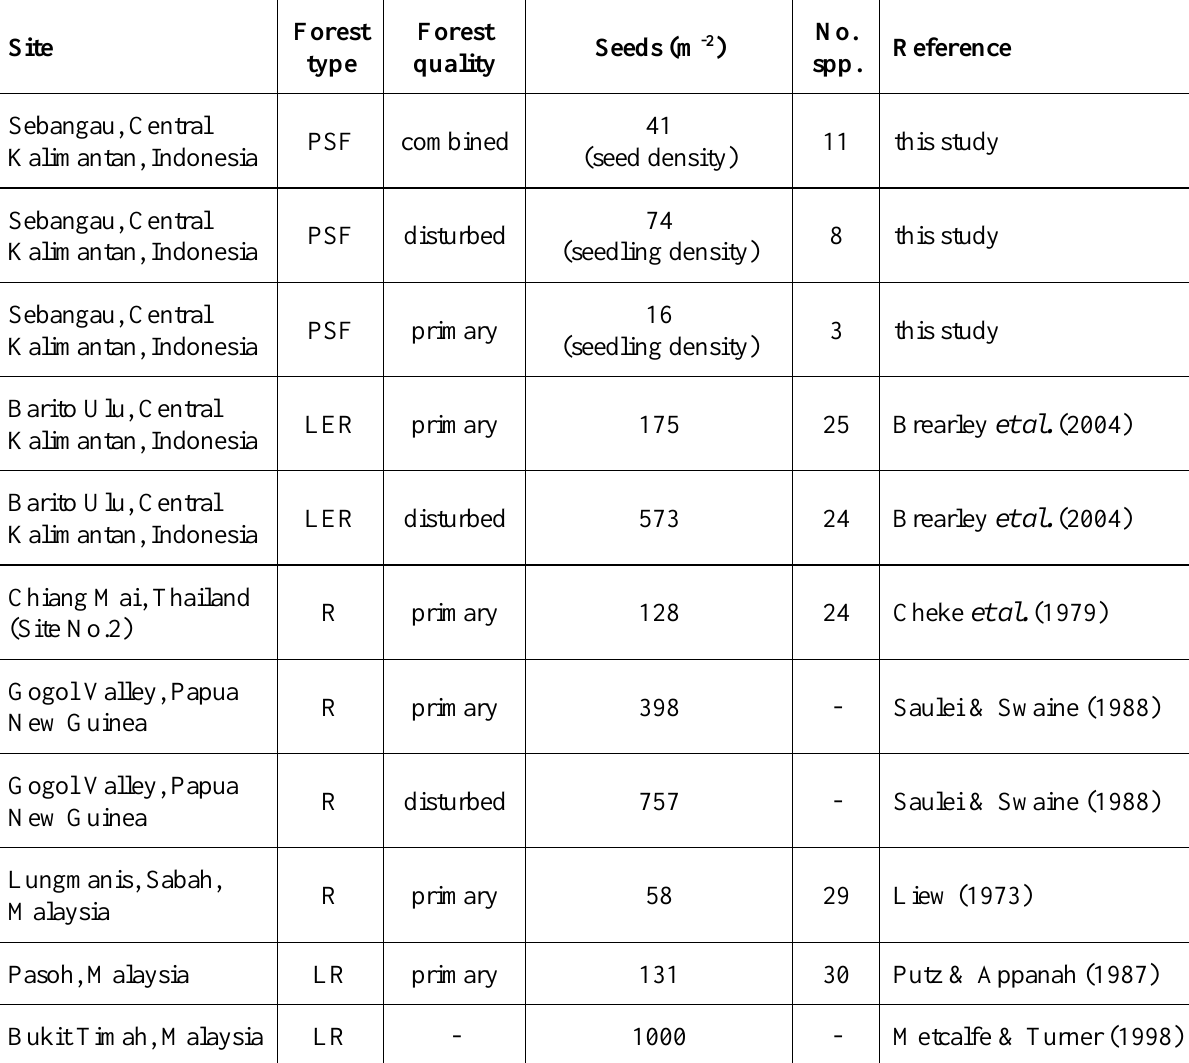
Table 4. Comparison of seed densities and number of species found in the seed banks of Southeast Asian rainforest study sites. PSF = peat swamp forest, LER = Tropical lowland evergreen rainforest, R = Tropical rainforest, LR = Tropical lowland rainforest. Adapted from Brearley et al. (2004) and Tang et al.